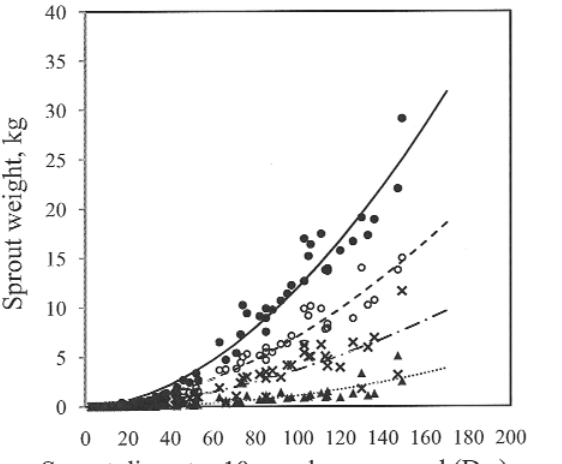
Figure 4. Dry mass per sprout (kg sprout − 1 ) as a function of diameter at 10 cm above ground (D ), mm of total ( ) for sampled 10 poplar stump sprouts growing on abandoned